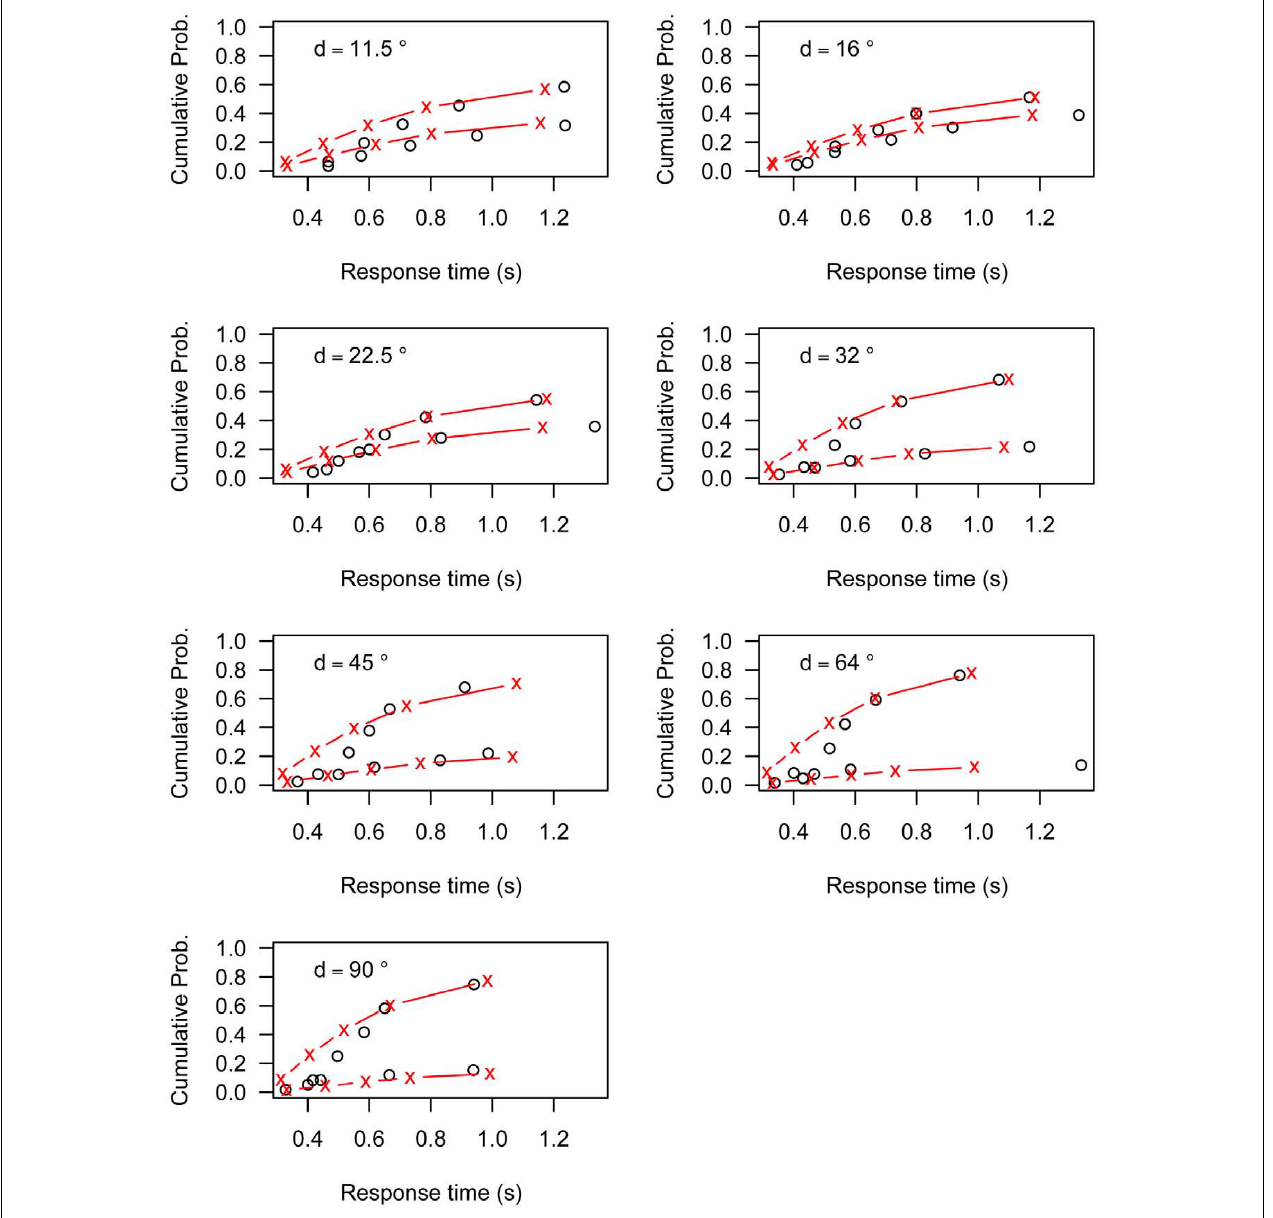
FIGUREA5 | LBA model fit for Participant